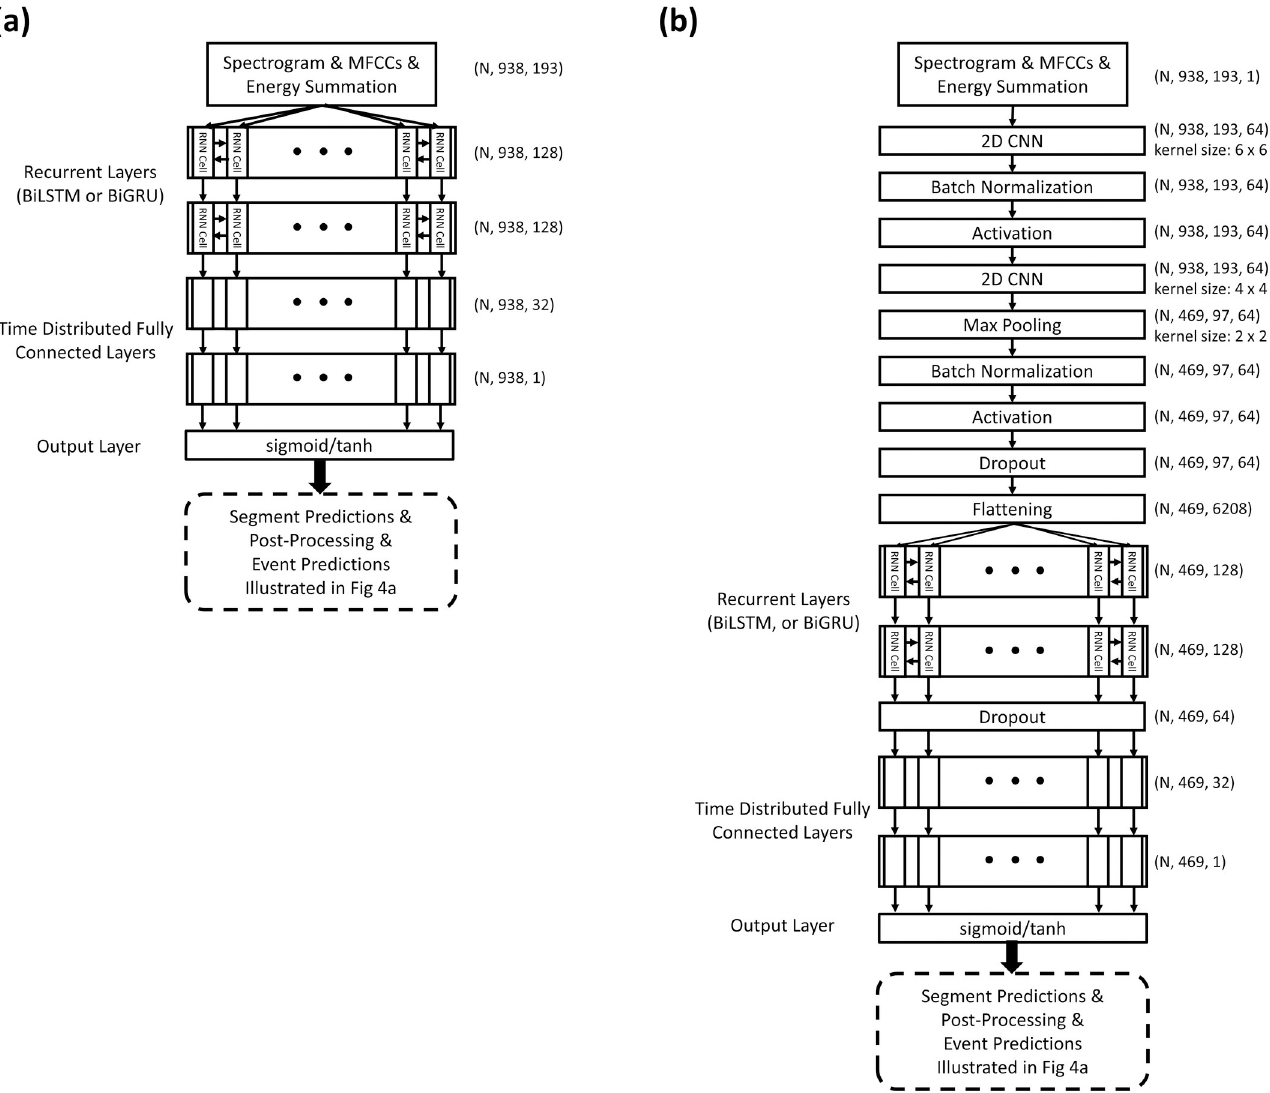
Fig 5. Architectures of simplified bidirectional models. (a) SIMP BiLSTM and SIMP BiGRU models; and (b) SIMP CNN-BiLSTM, and SIMP CNN-BiGRU models.